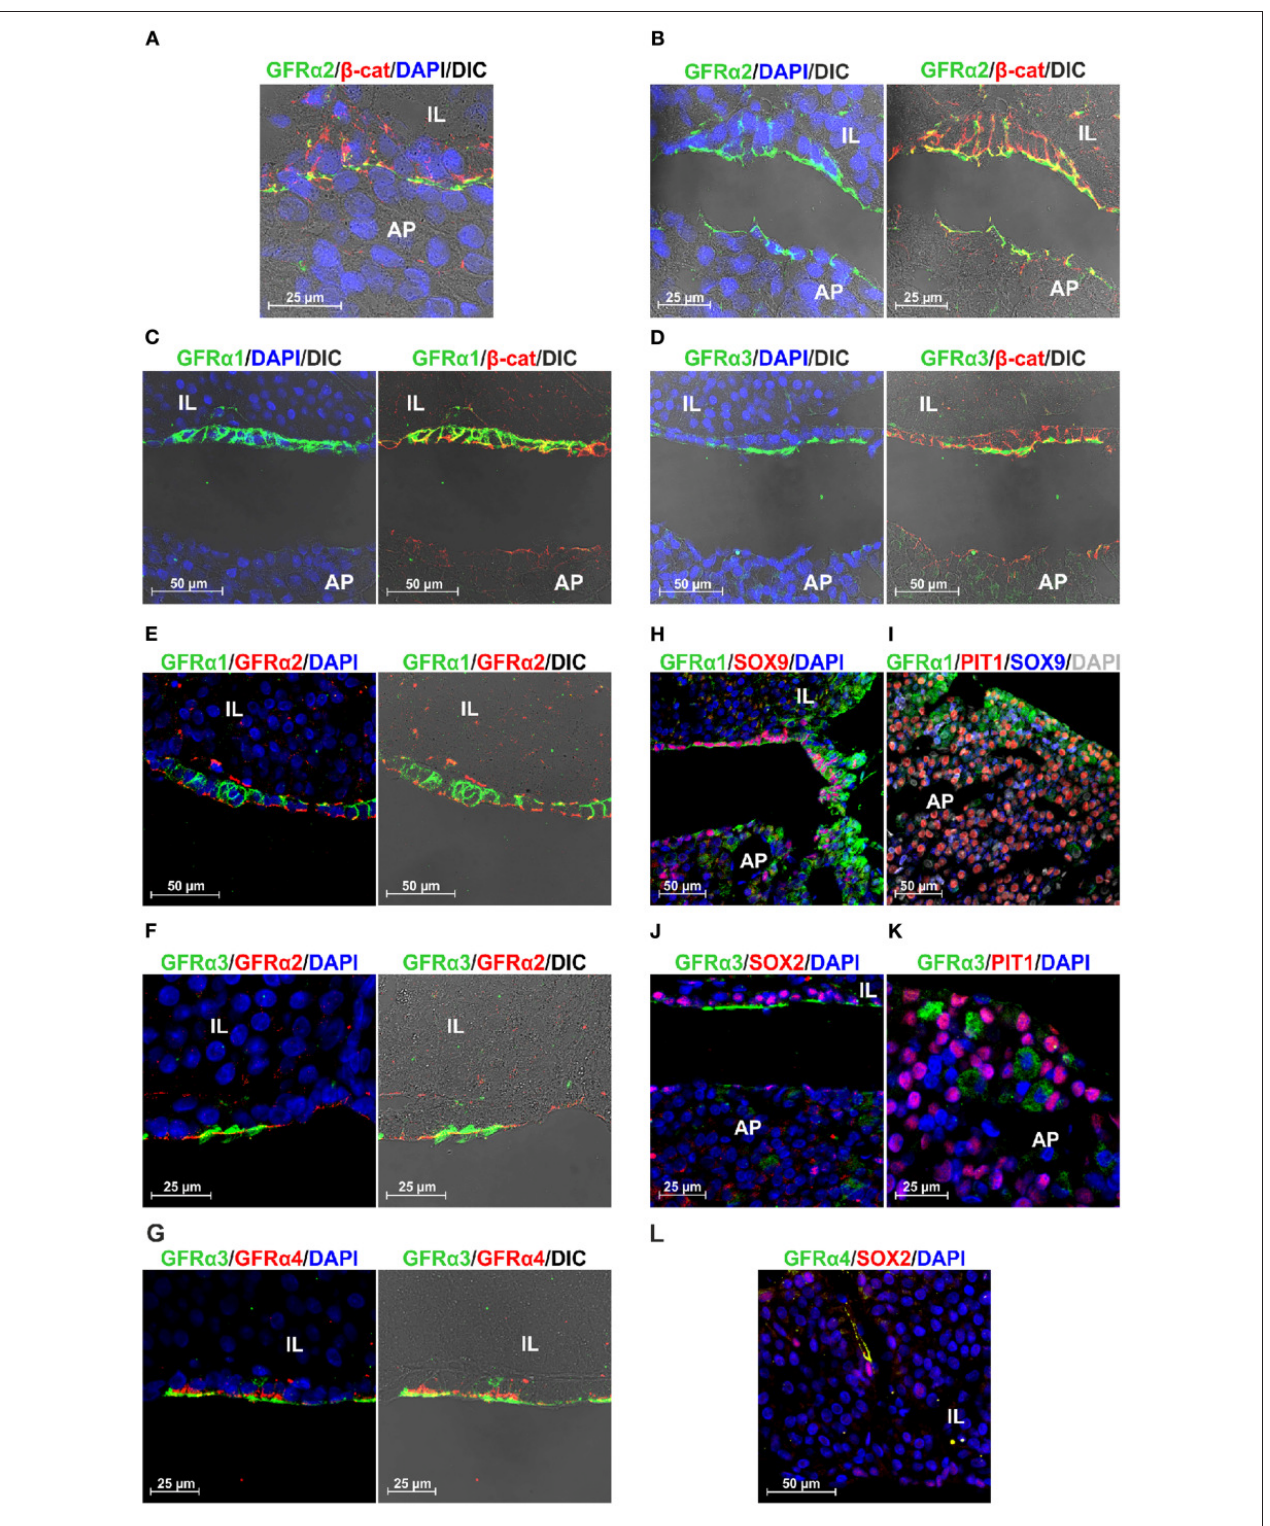
FIGURE 4 | Polarization and colocalization of the 4 GFR α at the niche but not in the AP. GFR α 1 is also expressed in PIT1 + cells. (A,B) Colocalization of GFR α 2 and β -catenin ( β -cat) at higher magnification in a rat pituitary sample that maintain its structure with a thin MZ (A) , compared to another that presents the usual fixation-induced retraction opening the MZ (B) . (B) GFR α 2 accumulates in the apical pole of the GPS cells residing in the stem cell niche, oriented toward the AP. (C) In contrast to GFR α 2, GFR α 1 is distributed along the plasma membrane of GPS cells. (D) GFR α 3 coincides with GFR α 2 in the apical pole oriented toward the